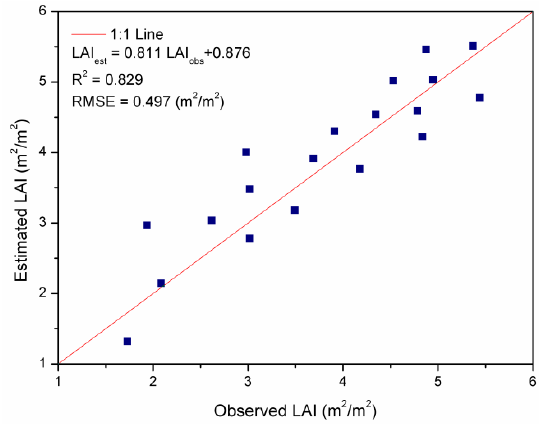
Figure 7. Comparison between observed and estimated values of LAI by